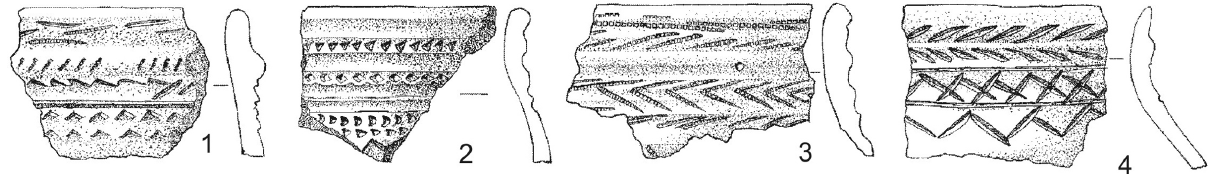
Figure 16: Cordoned ceramics of Fyodorovka culture (1, 2) and its transformation into Mezhovka forms (3, 4) in the Transurals: 1 – U Spasskogo Mosta, 2, 4 – Miasskoe, 3 – Kizilskoe (after Grigoriev,